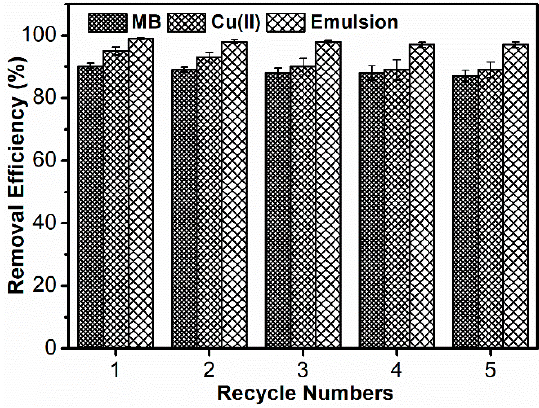
Figure 11. Removal efficiency for different adsorption-desorption cycles.